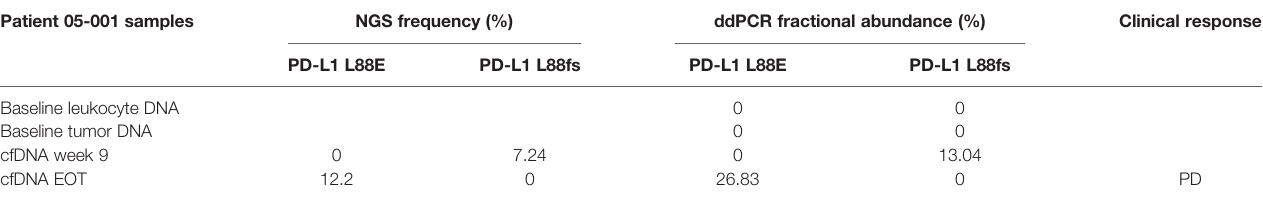
TABLE 1 | PD-L1 mutation frequencies in patient 05-001 across different timepoints.